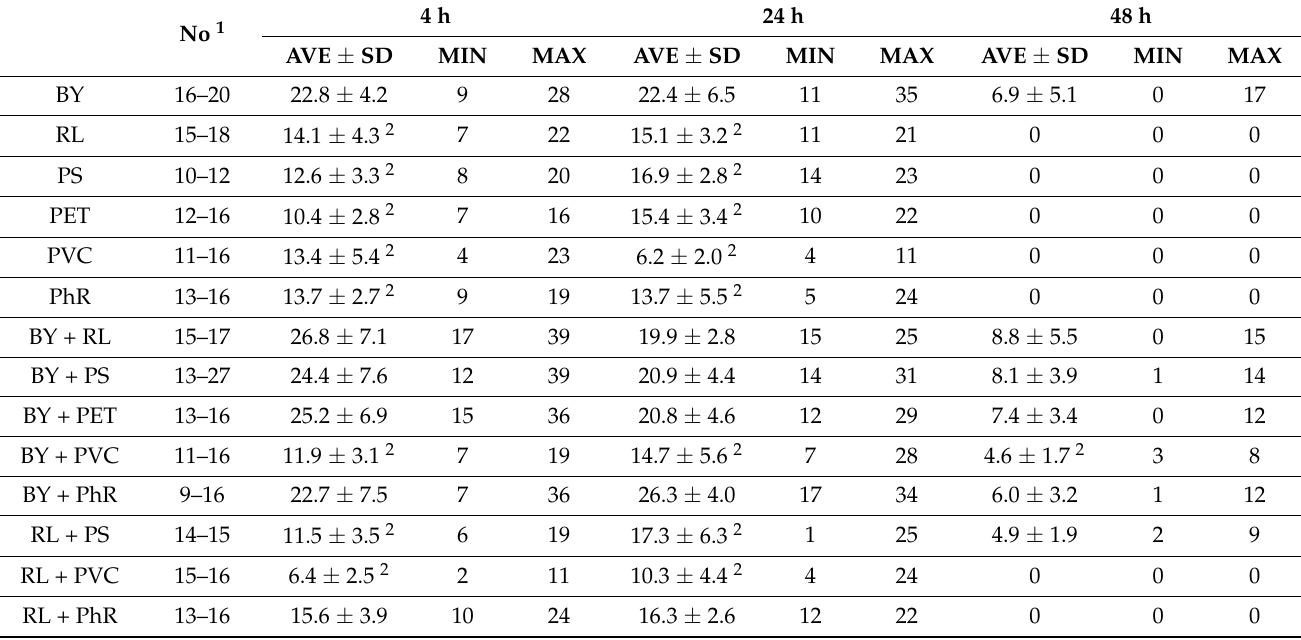
Table 2. Number of vacuoles formed by the protozoan S. ambiguum in different microparticle suspensions made of individual components and binary mixtures (1:1).